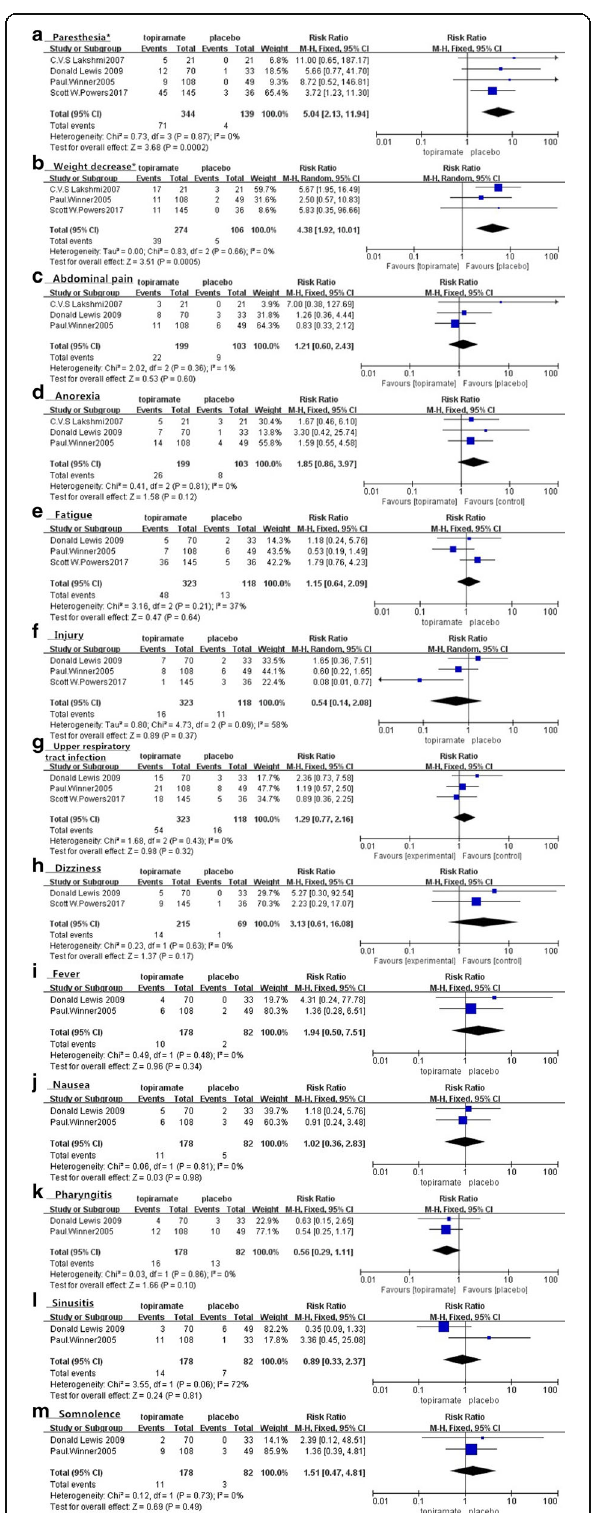
Fig. 6 Forest plot of comparison: Side effects/adverse events (a-m, respectively, represent paresthesia,weight decrease, abdominal pain, anorexia, fatigue, injury, upper respiratory tract infection, dizziness, fever, nausea, pharyngitis, sinusitis and somnolence) of topiramate versus placebo(*There was a significant difference between topiramate and placebo